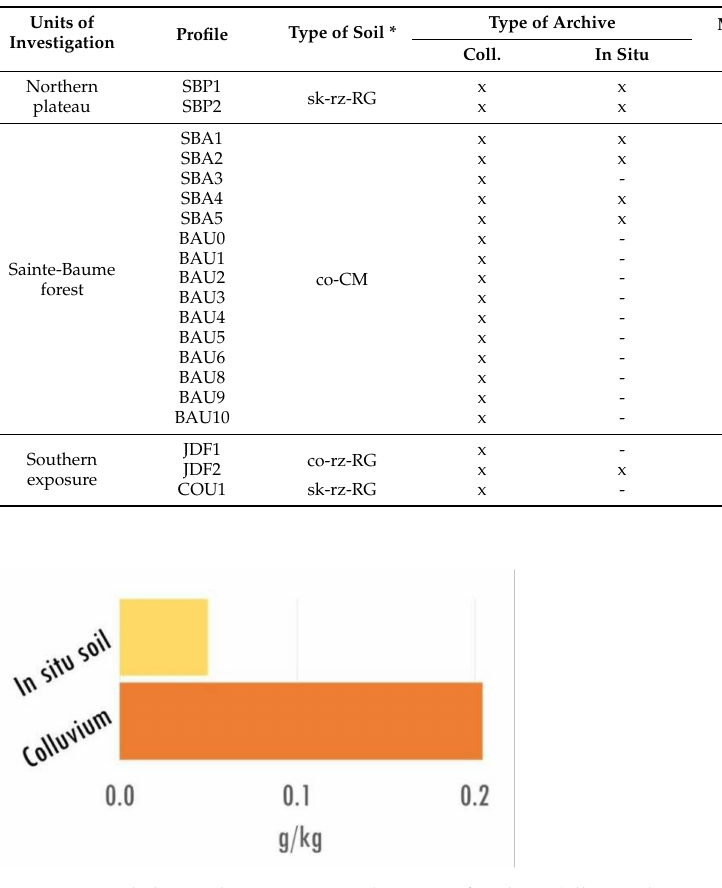
Figure 2. Total charcoal concentration by type of archive (all samples